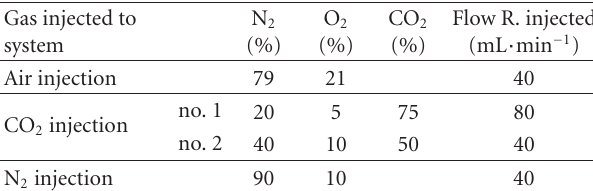
Table 2: Ambient gas contents.